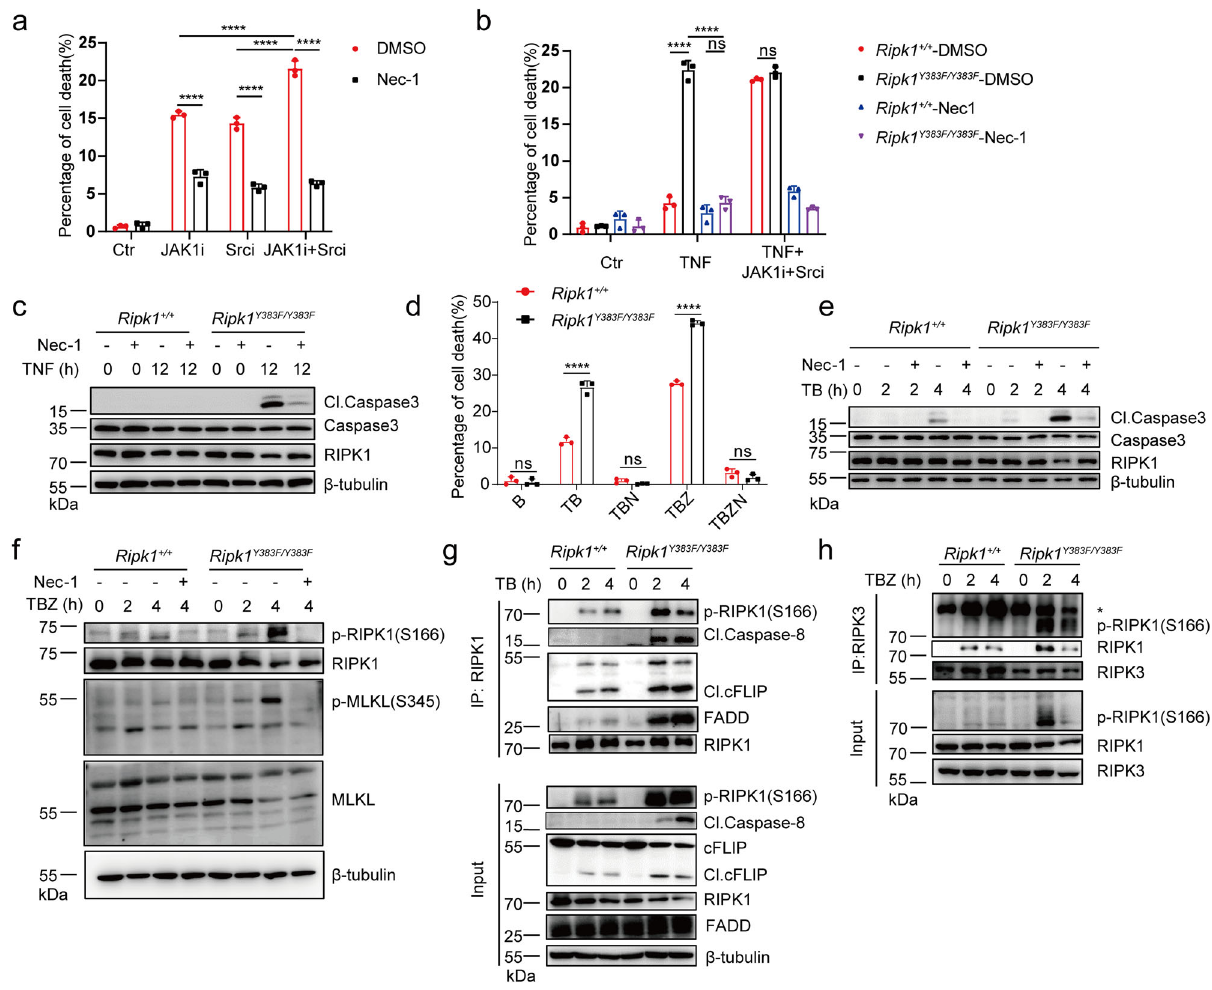
Fig. 3 | Loss of tyrosine phosphorylation of RIPK1 promotes TNF-induced apoptosisandnecroptosis.a PrimaryWTBMDMswerestimulatedbyTNFwithor without Nec-1 (RIPK1 inhibitor), JAK1 and SRC inhibitors for 24h, and cell death were measured by SytoxGreen positivity. b , c Primary Ripk1 +/+ and Ripk1 Y383F/Y383F BMDMs were stimulated by TNF with or without Nec-1 (RIPK1 inhibitor), JAK1 and SRCinhibitorsfor24h.Celllysateswerecollectedforwesternblotting( c )andcell death were measured by SytoxGreen positivity ( b ). d Primary Ripk1 +/+ and Rip- k1 Y383F/Y383F BMDMs were treated by different stimulators for 6h. Cell death were measuredbySytoxGreenpositivity.T:TNF;B:BV-6;Z:zVAD.fmk;N:Necrostatin-1. Primary Ripk1 +/+ and Ripk1 Y383F/Y383F BMDMs were stimulated by TNF/BV-6 ( e ) and